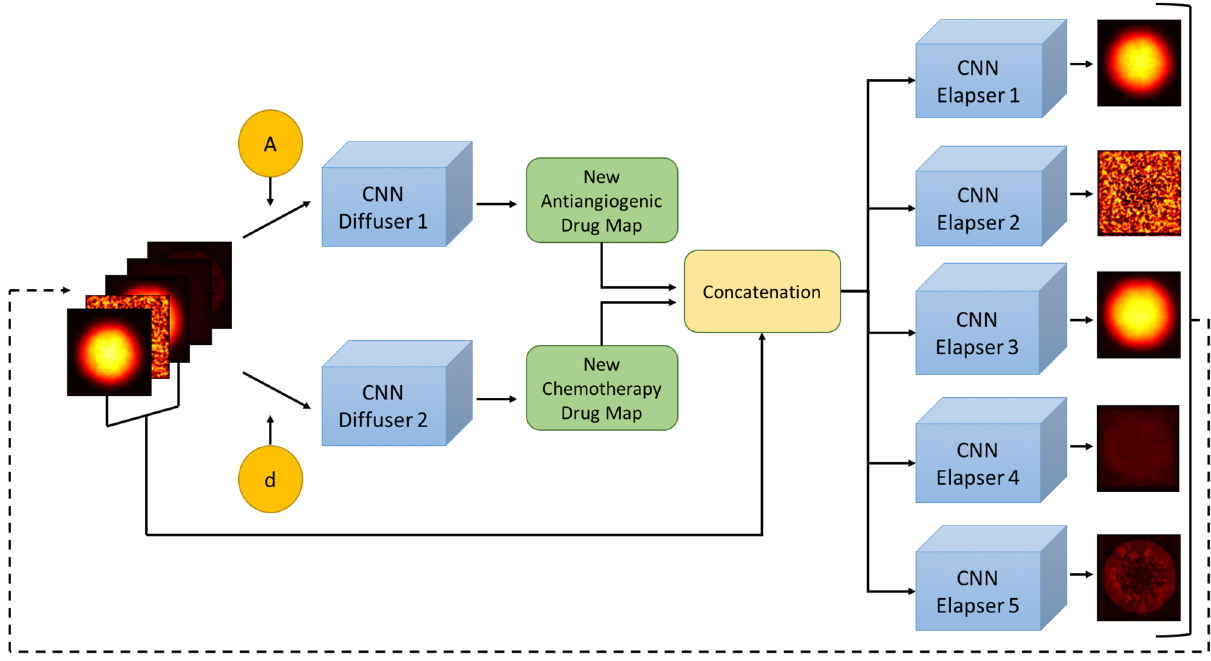
Figure 6. The model diagram. The model takes the five-channel tumor microenvironment maps with antiangiogenic drug dosage (A) and chemotherapy drug dosage (d). The Diffuser submodel predicts new antiangiogenic and chemotherapy drug diffusion maps, then tumor density, vasculature, and IFP maps are concatenated with new drug diffusion maps. The Elapser submodel takes the concatenated tumor microenvironment maps and predicts tumor microenvironment maps of the next day. The model can predict tumor microenvironment maps over time, as it has the capacity to use the final prediction as an